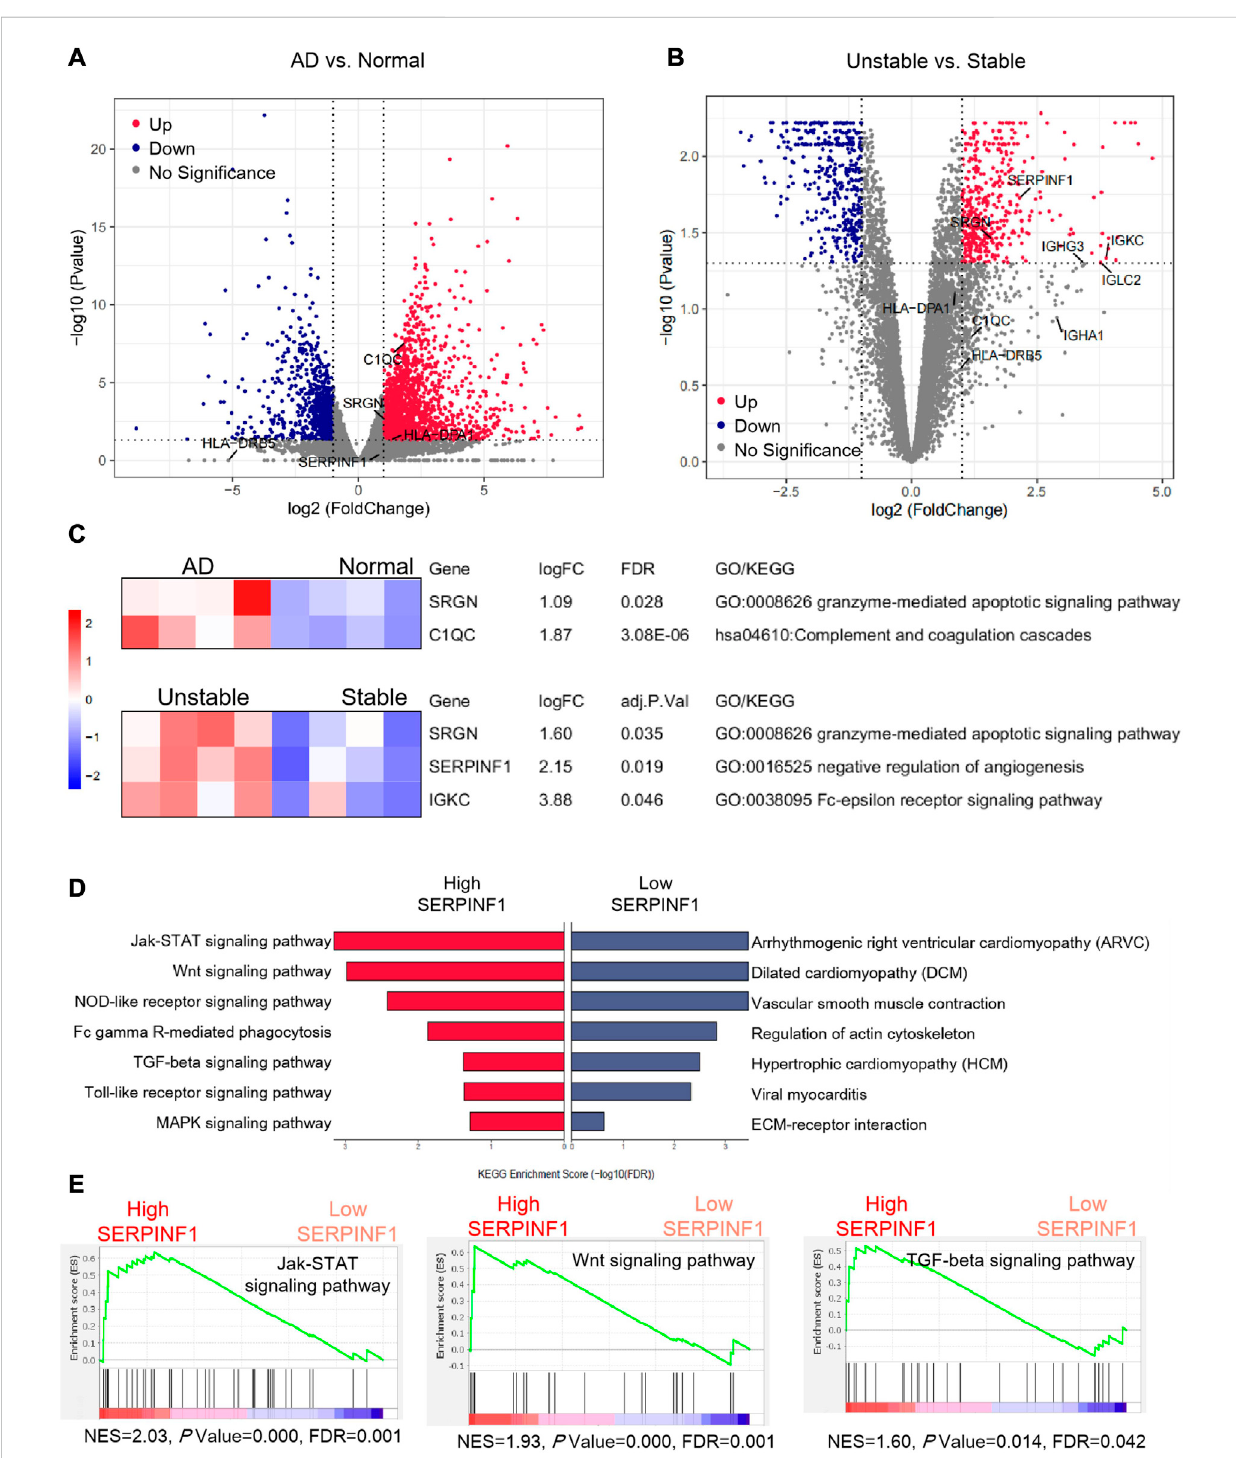
FIGURE 6 Bulk RNA-seq analysis and gene set enrichment analysis. (A) Volcano plot showing differential expression of genes in dissection tissues and normal tissuesofarteries.Fournormalhumanarterysamplesandfourdissected humanarterysamplesareusedtoidentifyDEGs(differentially expressedgenes). (B) Volcano plot showing differential expression of genes in stable and unstable atherosclerotic plaques. Four stable human arterial plaque samples and fourunstablehuman arterial plaquesamplesarecomparedto gainDEGs. The p values arebyan empiricalBayesmoderated t-statistics test,andadj. P represents Benjamini-Hochberg adjusted p -value (C) Heat map showing the z-score scaled relative expression levels of DEGs, and GO/KEGG annotations showing the related biological processes of DEGs. (D) The enrichment results of fi broblasts and fi bromyocytes from eight human atherosclerotic artery samples using gene set enrichment analysis. (E) Important signaling pathways enriched by gene set enrichment analysis. p values are estimated by an empirical phenotype-based permutation test. The analysis data comes from GSE147026 (Normal arteries: